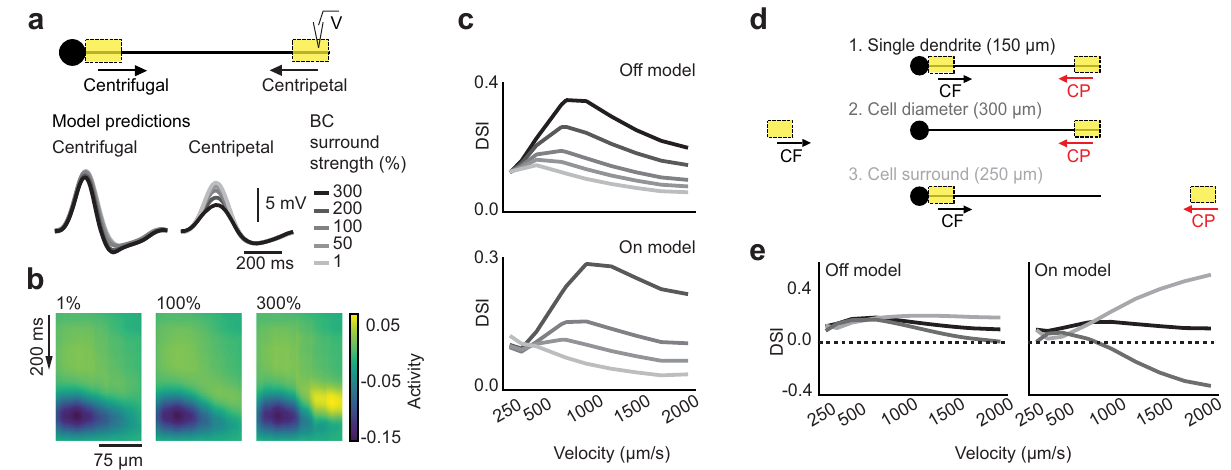
Fig. 7 | Bipolar cell surround properties shape direction selectivity of model starburstamacrinecell.a Top:ball-and-stickmodelstarburstamacrinecell(SAC), same as in Fig. 6). Bottom: Predicted responses to a moving bar (1000 μ m/s) for SAC models using BC RFs with different surround strengths. b Superposition of all BCRFspresynaptictotheOffmodelattheirrespectivepositionsalongthedendrite at increasing BC surround strengths. c Directional tuning (DSI) of the Off and On SAC dendrite models with input from BCs with different RF surround strengths.